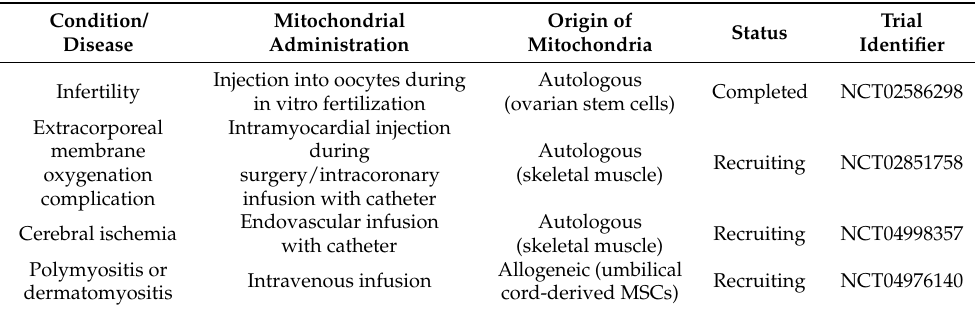
Table 3. Clinical trials using mitochondrial